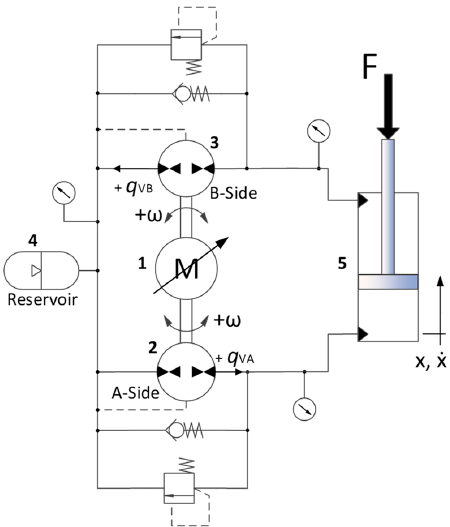
Figure 1. The hydraulic circuit of the test bench. Table 1. Main parameters of the components in the setup.